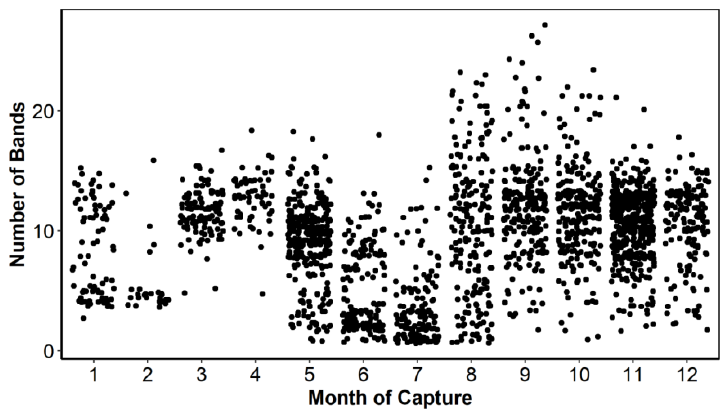
Figure 2. Number of samples identified by number of bands and month of capture.